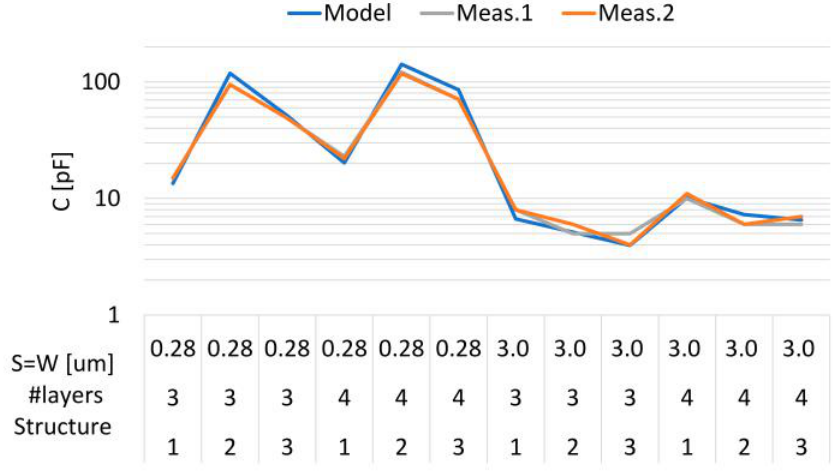
Figure 11. Measured vs. model